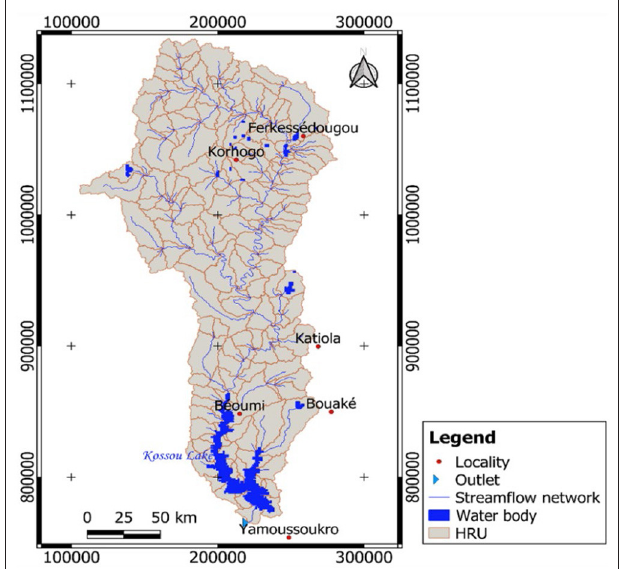
FIGURE 8 | Spatial distribution of the extracted HRUs in the WBW.